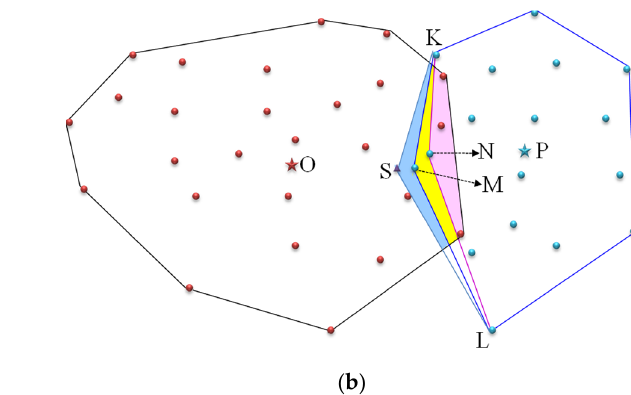
Figure 7. Identification method of the convex service area corresponding to the fire station. ( a ) Re- cursive principle. ( b ) Overlapping coverage area. (The red and blue stars (O and P) represent the different fire stations; The red and blue dots represent POIs within the convex hull covered by fire stations O and P respectively; The letters except O and P represent the POIs selected for analysis.)